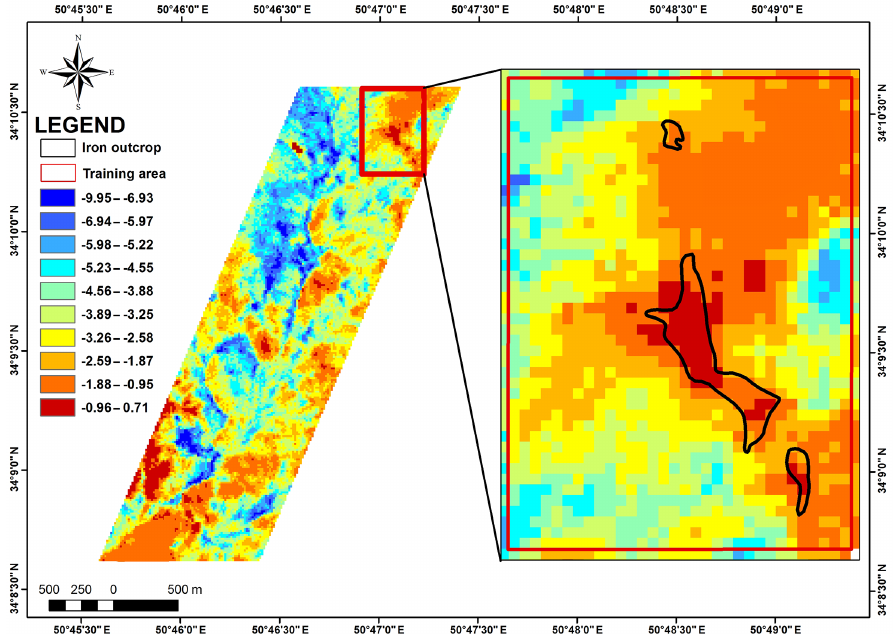
Figure 5. Mineral prospectivity map of the Sarvian area, which is confirmed by iron